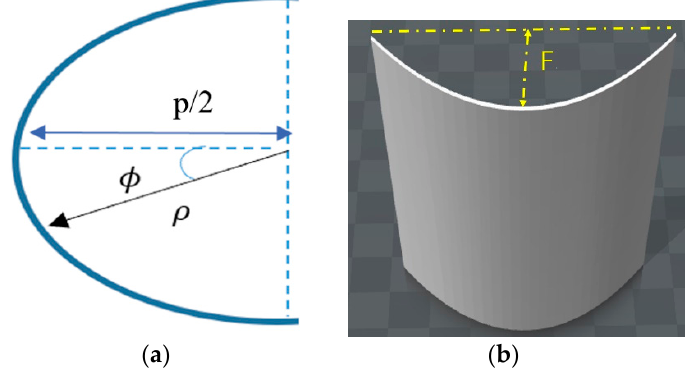
Figure 3. Parabolic reflector. ( a ) Parabolic curve (b) 3D structure.